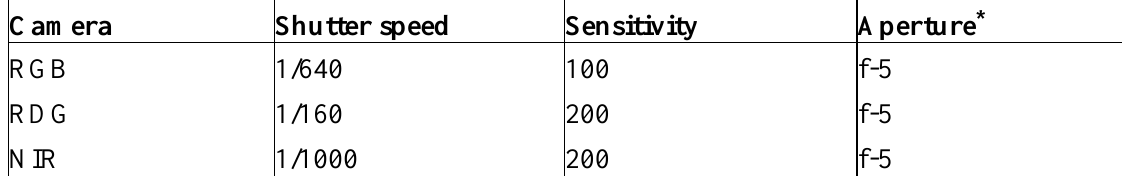
Table 1. CANON EOS 400D camera